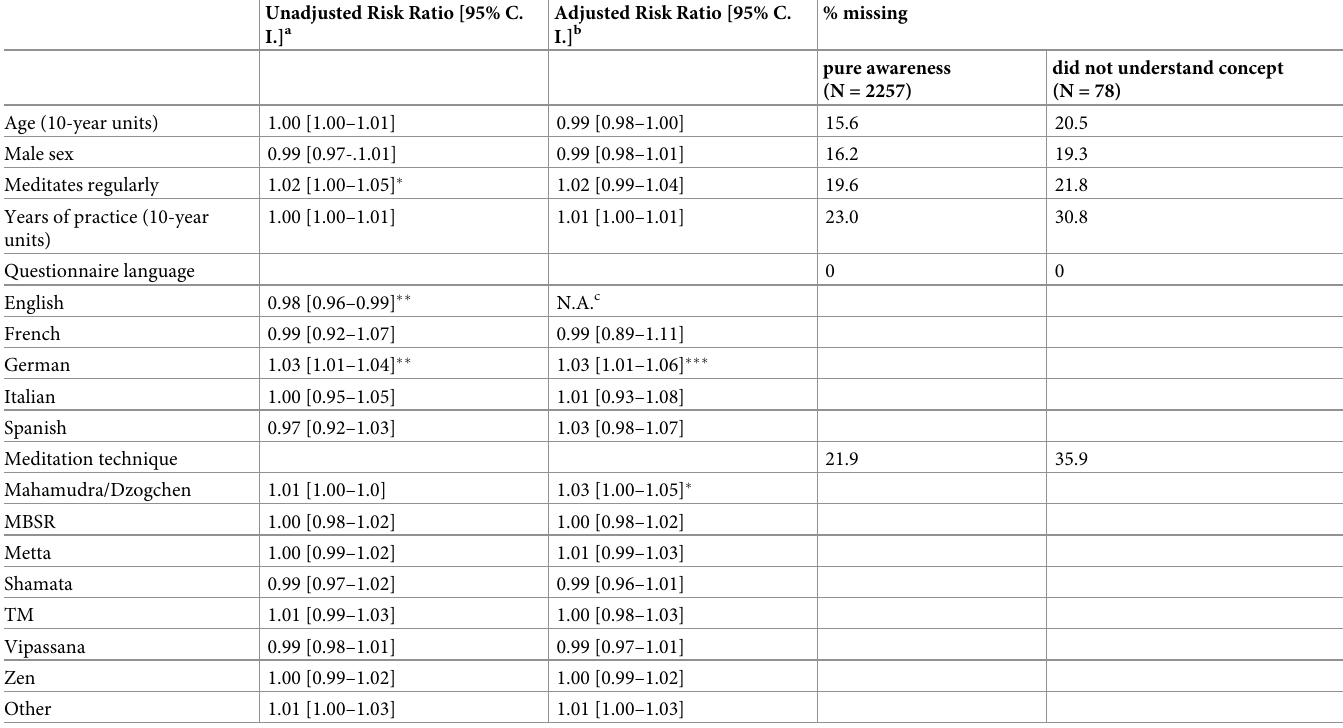
Table 3. Risk ratios comparing participants with an experience of pure awareness (N = 2257) to those not understanding the concept of pure awareness (N = 78). Unadjusted Risk Ratio [95% C. I.] a